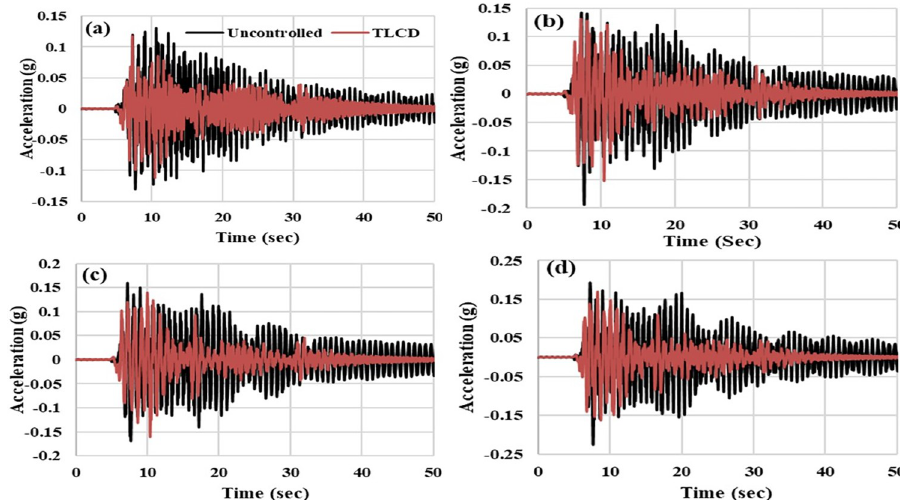
Fig 12. Acceleration time history responses of the MDOF structure equipped with and without TLCD at seismic loading, (a) Storey Level -01, (b) Storey Level -02, (c) Storey Level -03, (d) Storey Level -04.